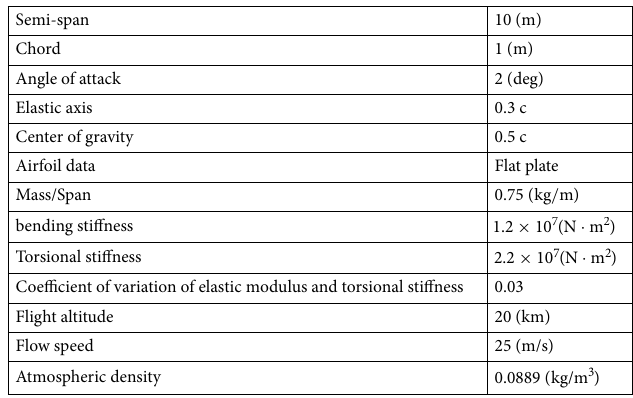
Table 2. Simulation data.